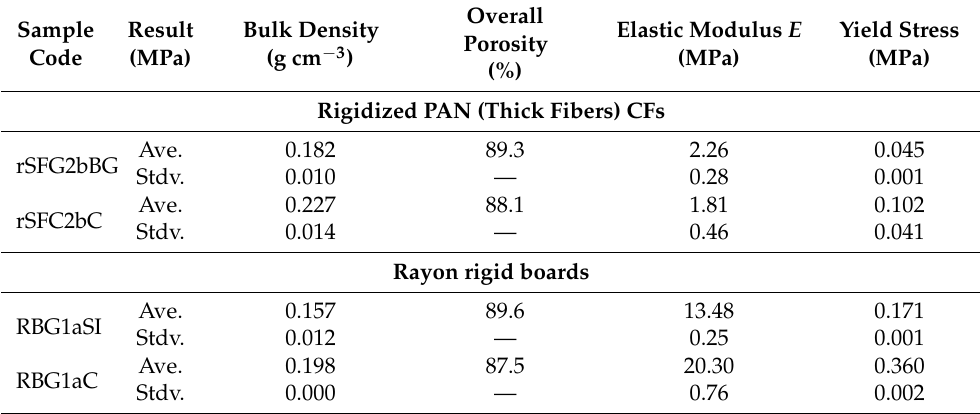
Table 1. Sorting of the CFs investigated here into groups, depending on their main characteristics. “Ave.” and “Stdv.” stand for average and standard deviation,